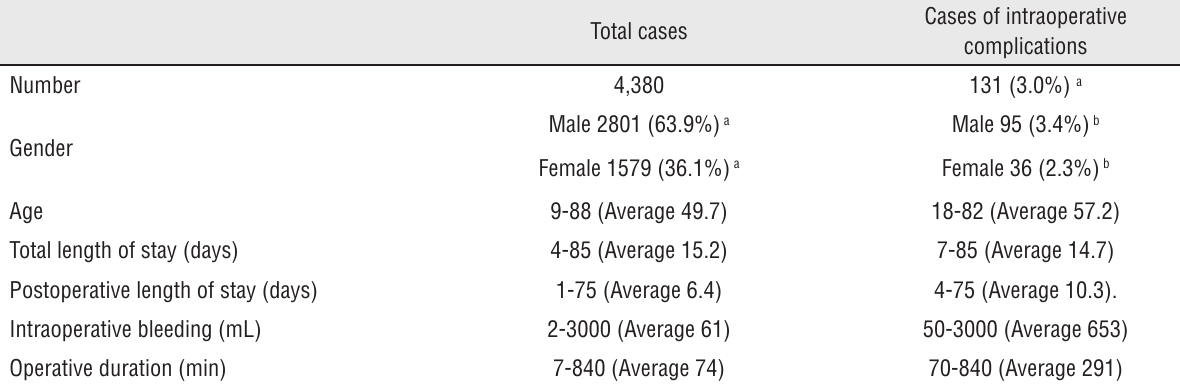
Table 1 - General information of the total cases and 131 cases with intraoperative serious